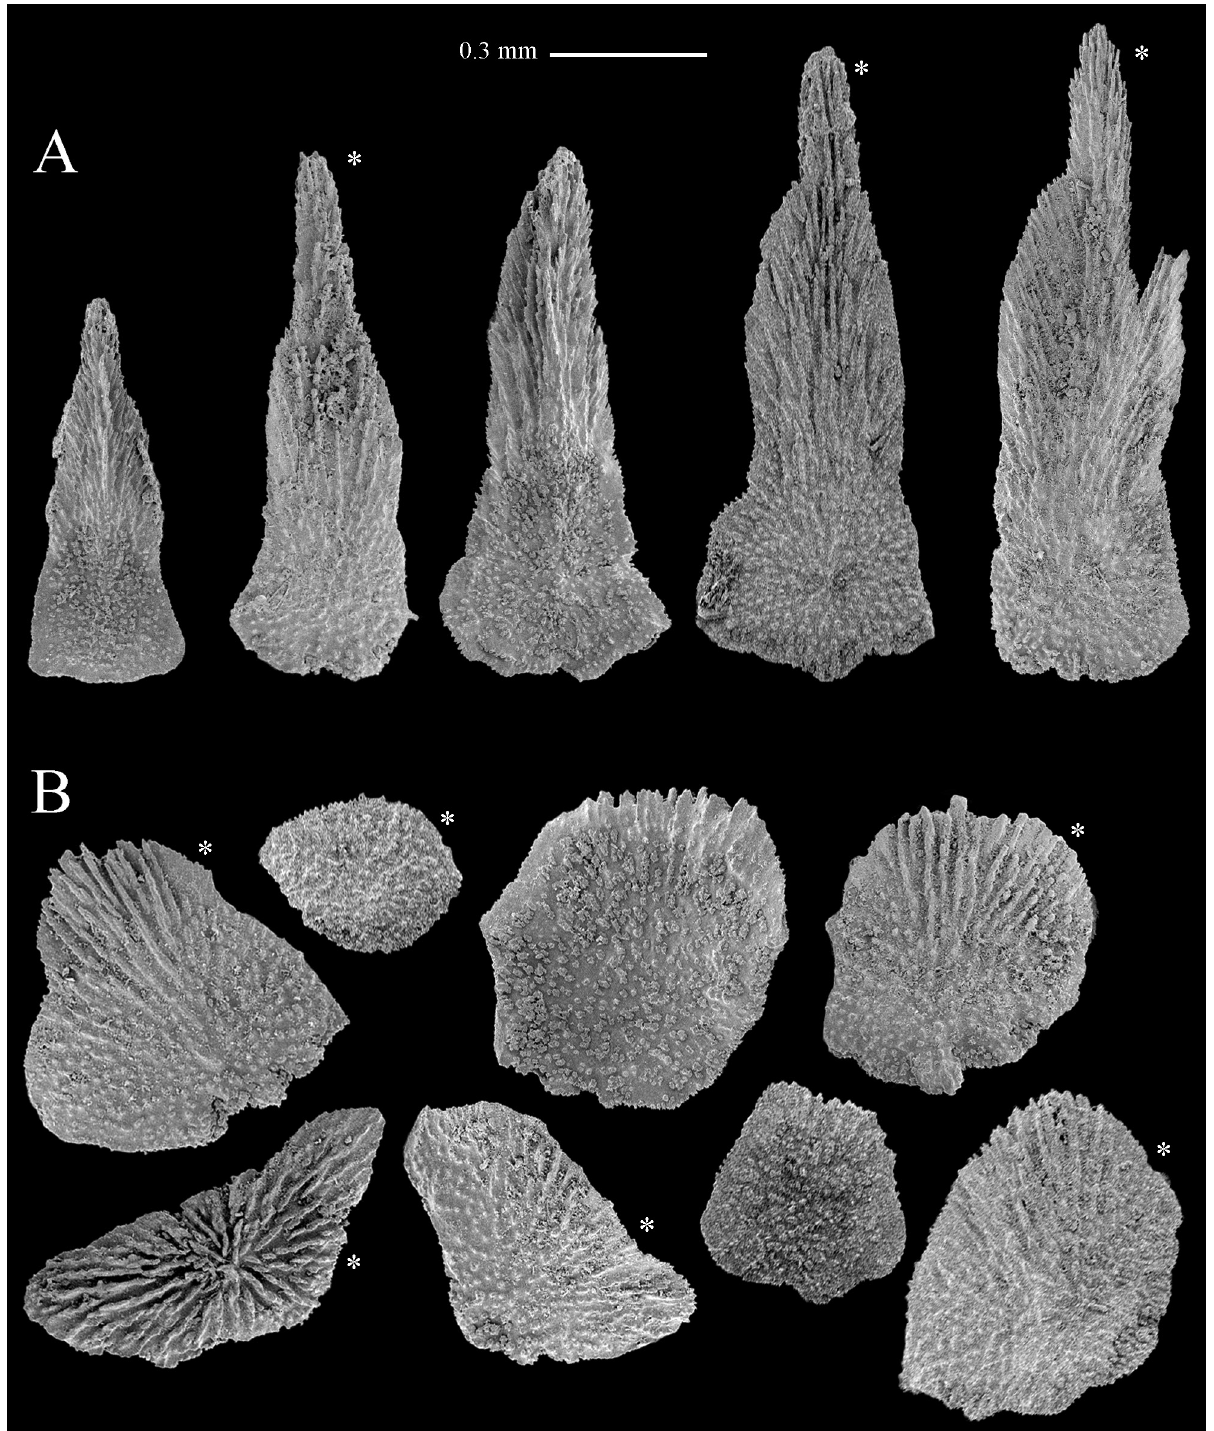
Fig . 22. – Plumarella ( Faxiella) abietina (Studer, 1894) n. comb., holotype (MCZ 4802): A, opercular scales; B, marginal and body scales. [*outer surface view; photo: Stephen D. Cairns, NMNH,